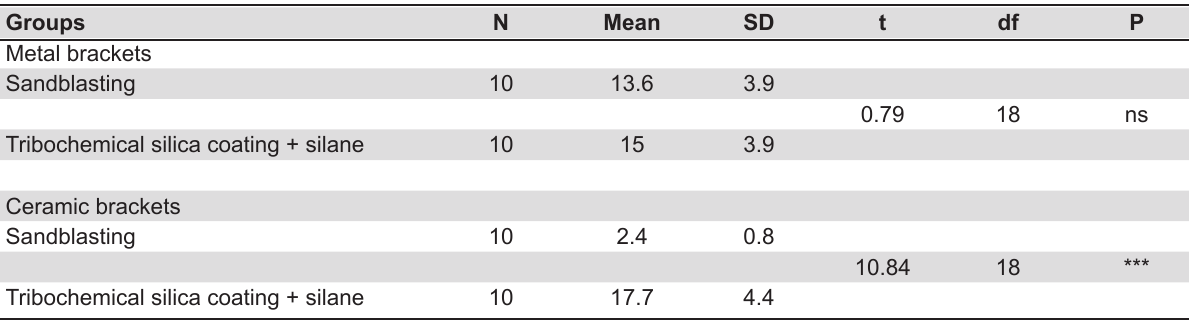
Table 1- Results of t-test for rebonded metal and ceramic brackets